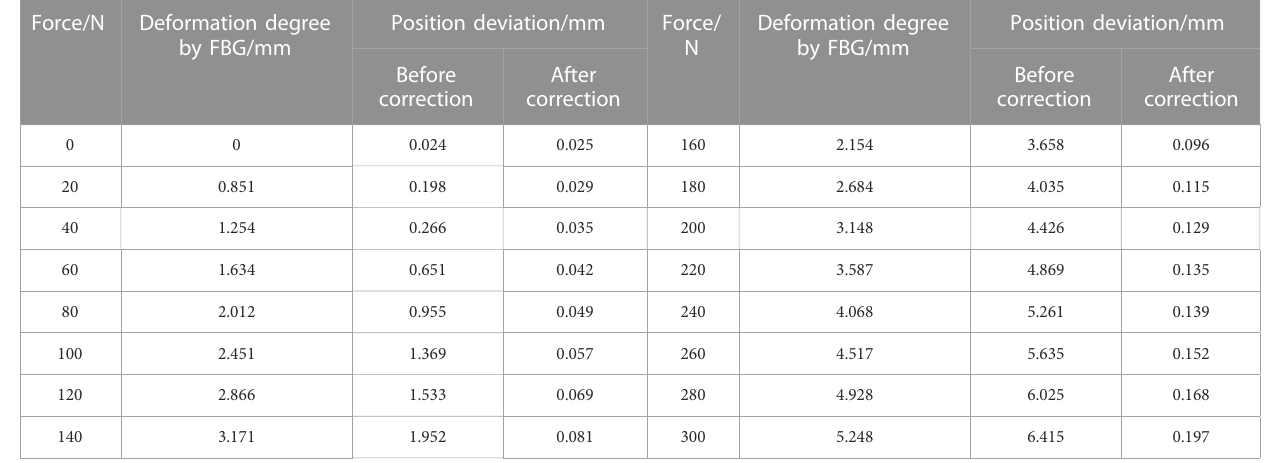
TABLE 1 Position test